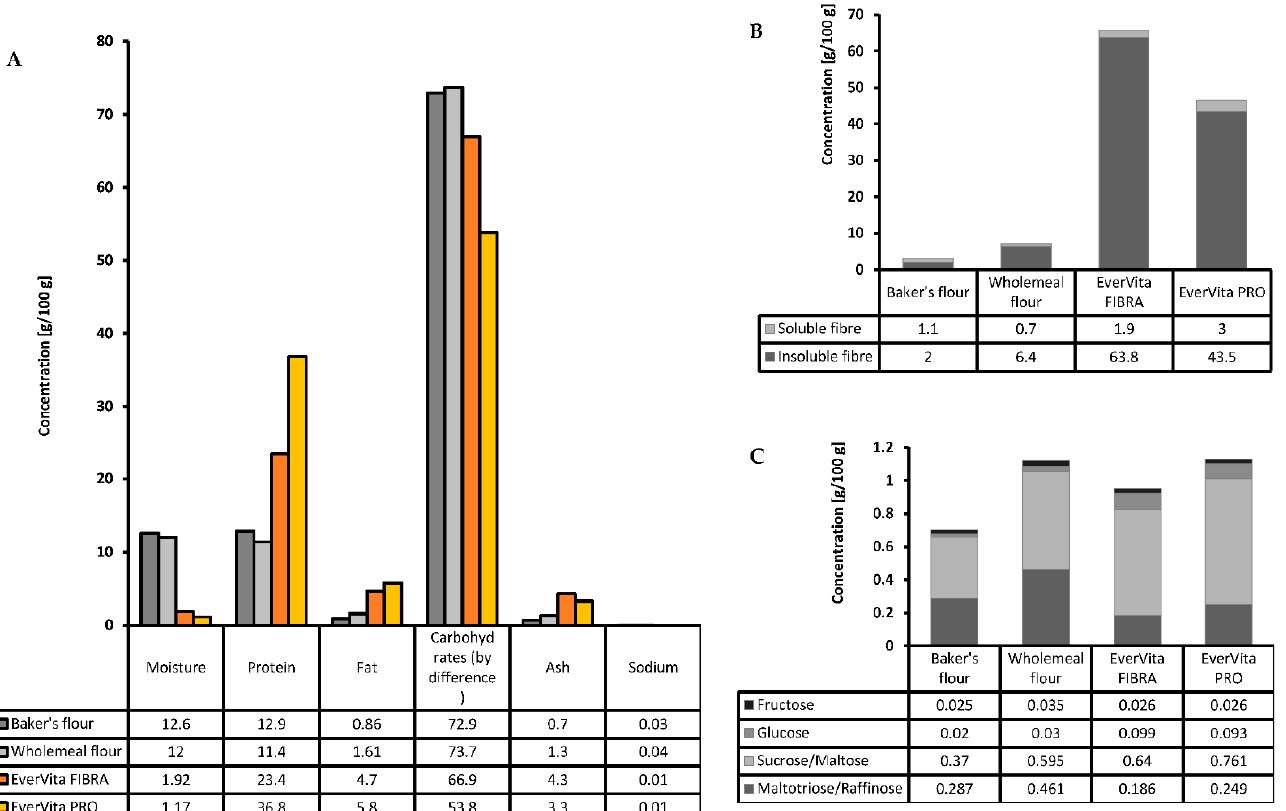
Figure 1. Composition of the raw ingredients baker’s flour, wholemeal flour and EverVita ingredients, EverVita FIBRA and EverVita PRO ( A ), including the sugar profile ( B ) and the amount of soluble and insoluble dietary fibre ( C ). Values are expressed as mean values with a coefficient of variation < 0.1.